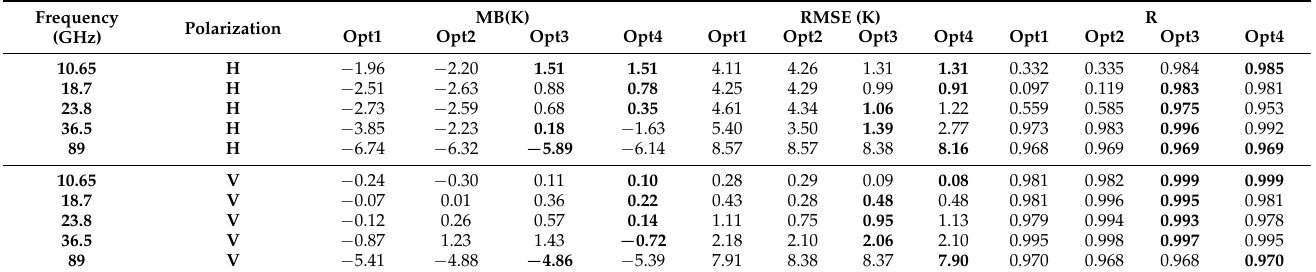
Table 3. Statistics for mean bias (MB), RMSE, and correlation coefficient (R) of simulated brightness temperature in different bands and polarizations (Altay samples). The sample size was 3016. The values in bold represent the highest accuracy among four methods.